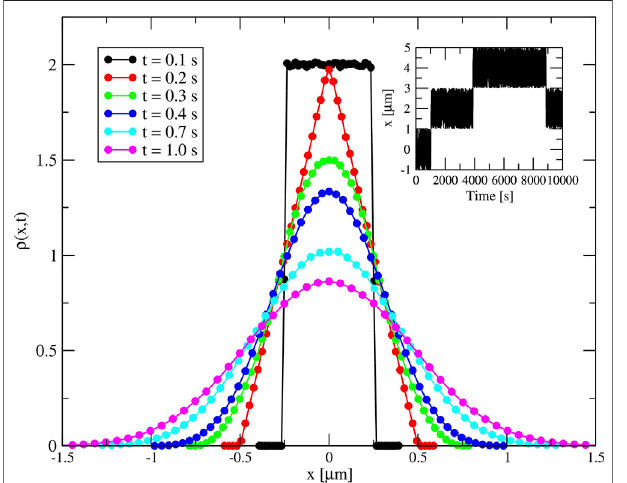
FIGURE 3 | (Color online): Mean square displacement MSD(t) of a spherical tracer as a function of time. The red solid squares and the blue dashed line correspond to the total mean square displacement (associated to the free diffusion in the y − and x − axis directions) associated to experimental and Brownian dynamics results, respectively, in the absence of an external fi eld. The black solid circles and the magenta dot-dashed line correspond to the MSD(t) in the x − axis associated to experimental and Browniandynamicsresults, respectively, in the presence ofaperiodic cosine- like external fi